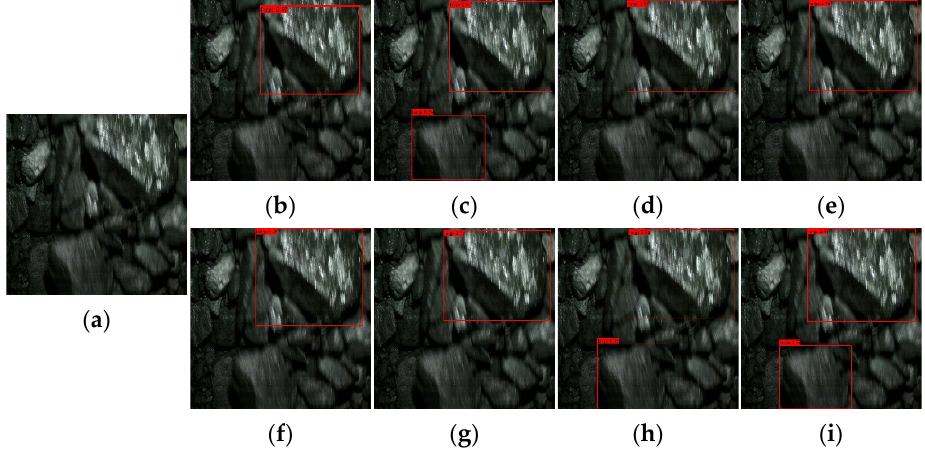
Figure 11. Results of big coal block detection via different networks—the third image. ( a ) origin;